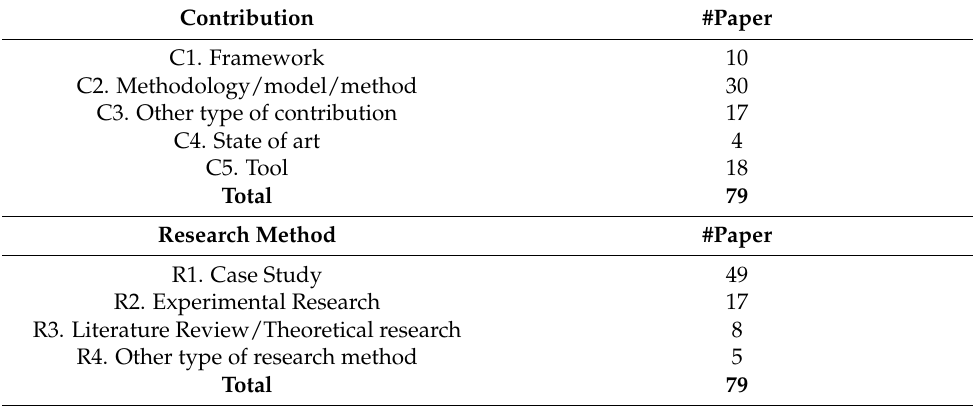
Table 2. Types of contribution and research method.